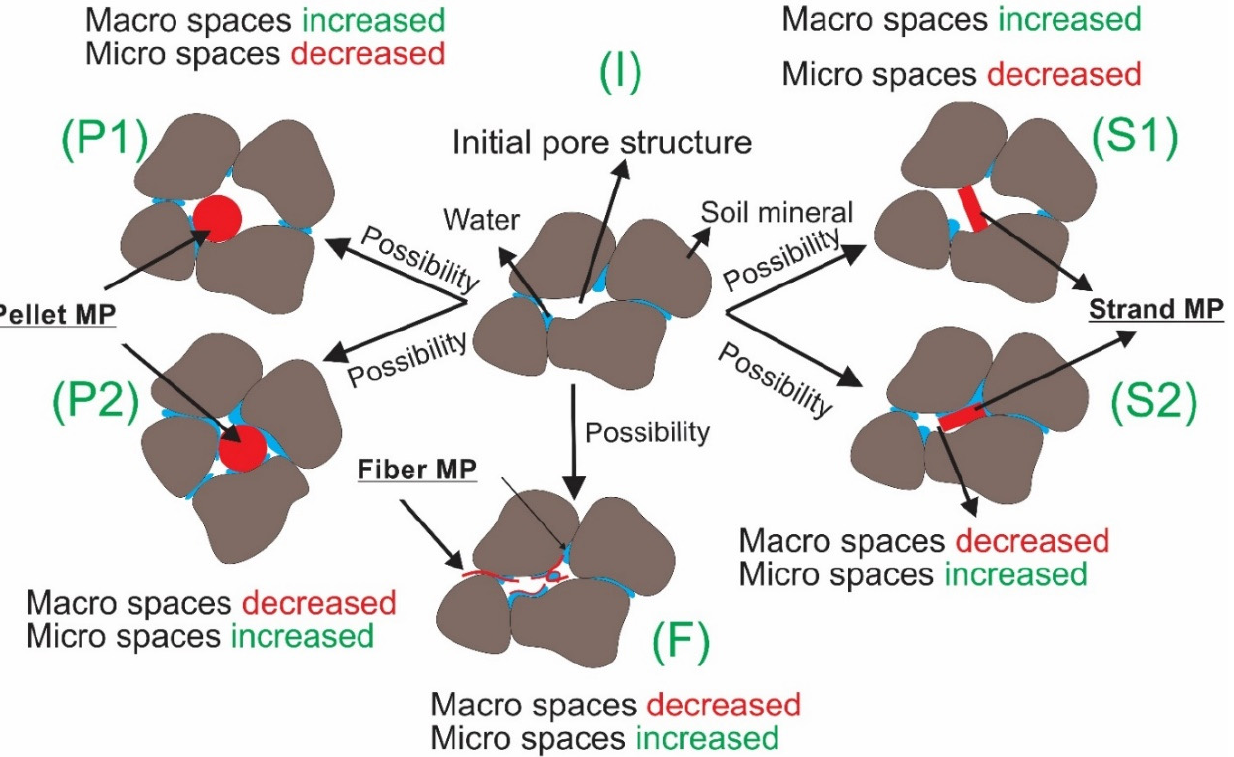
Figure 3. An illustration of a few scenarios of how pellet, strand, and fiber MP can alter the pore structure of sandy soil. A clean soil’s initial pore structure is shown in (I). As shown in Figures (P1 and 2) and (S1 and 2), soil micropore and macro pore structure can increase or decrease depending upon different soil mineral arrangements, while polluted by pellet and strand MP, respectively.